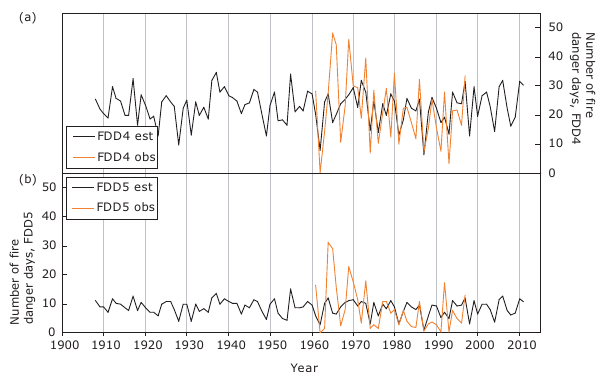
Fig. 6. Estimated number of fire danger days (black line) in North Karelia (a) FDD4 and (b) FDD5 in 1908–2011. Red line shows the calculated number of the fire danger days based on the FFI data in 1961–1997.